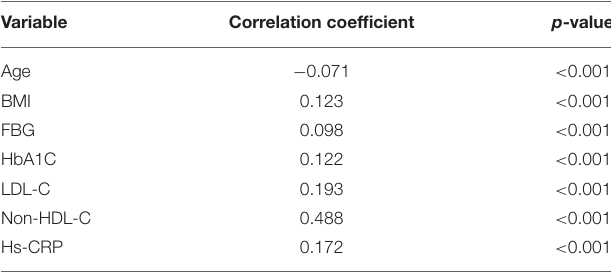
TABLE 2 | Spearman’s correlation coefficients of RC level with covariates.